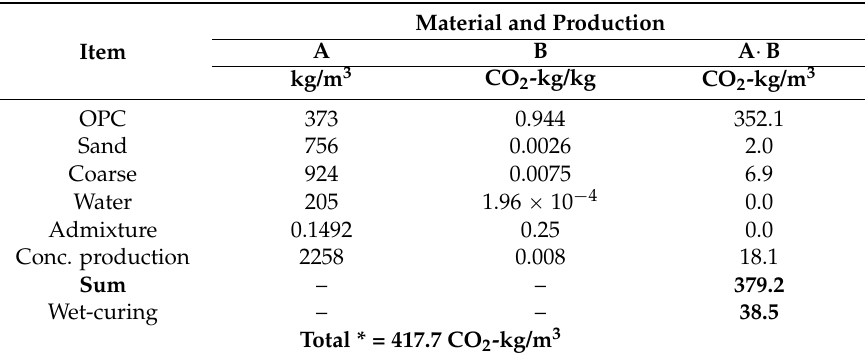
Table 6. CO 2 evaluation of OPC concrete.